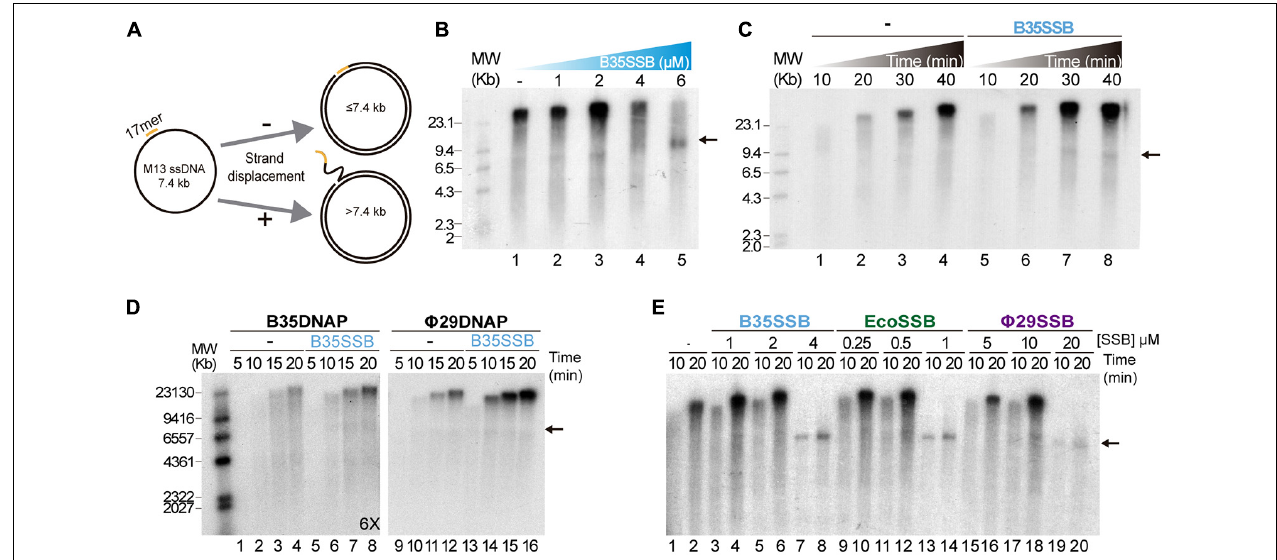
FIGURE 2 | B35SSB stimulation of processive DNA replication. (A) Schematic representation of M13 ssDNA rolling-circle replication. In strand-displacement conditions, a product much larger than the full-length M13-DNA (7.4 kb) is obtained. (B) Effect of B35SSB concentration in ssDNA M13 replication. Reactions were carried out for 20 min as detailed in Methods. (C) Time-course analysis of addition of B35SSB. Reactions in absence or presence of 2 µ M B35SSB were carried out and stopped at the indicated times. (D) Stimulatory capacity of B35SSB (2 µ M) on M13 DNA replication performed by Bam35 and (cid:56) 29 DNA polymerases. Longer autoradiography exposition time is indicated. (E) Effect of different SSBs on B35DNAP processive DNA replication. Reactions were carried out using primed M13 circular ssDNA as template and the indicated DNA polymerase. After incubation at 37 ◦ C, the length of the synthesized DNA was analyzed by alkaline 0.7% agarose gel electrophoresis alongside a λ DNA (MW) and autoradiography. M13 ssDNA unit length is indicated by a black arrow. See section “Materials and Methods” for